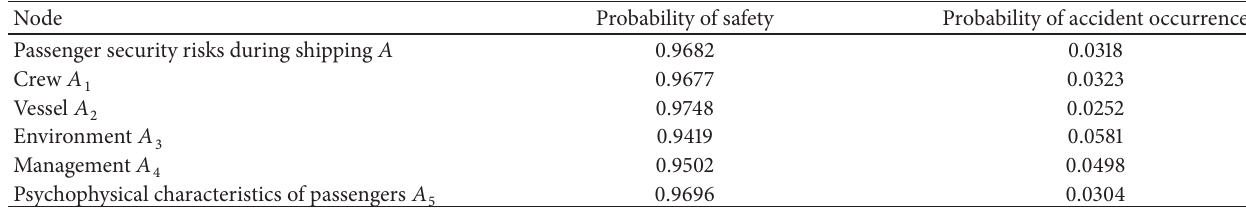
Table 10: Safety probability of Passenger 1.